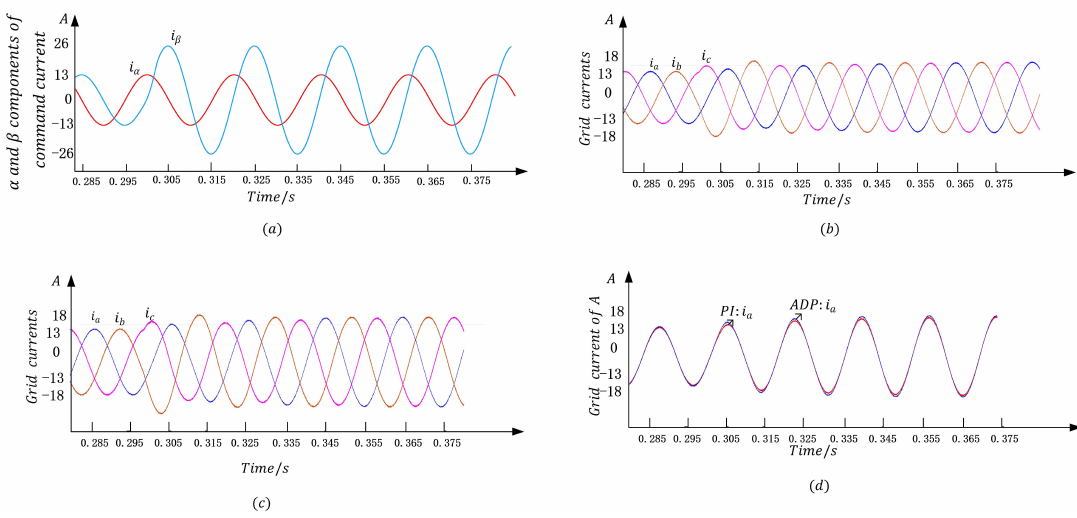
Figure 8. α and β components of command currents ( a ). Grid currents of PI closed-loop control ( b ). Grid currents of ADP closed-loop control ( c ). Two control methods’s Phase A current comparison ( d ). Table 2. THD of grid